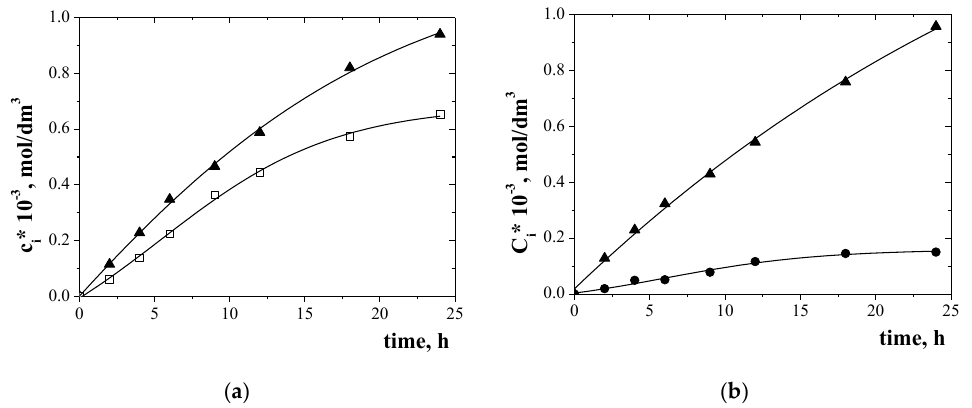
Figure 5. Change in the concentration of Zn (II) ( ▲ ) and Cr (III) (□) ( a ), and Zn (II) ( ▲ ) and Ni (II) (●) ( b ) in the receiving phase during transport through PIMs doped EDAB-acac. Conditions as in Table 3.